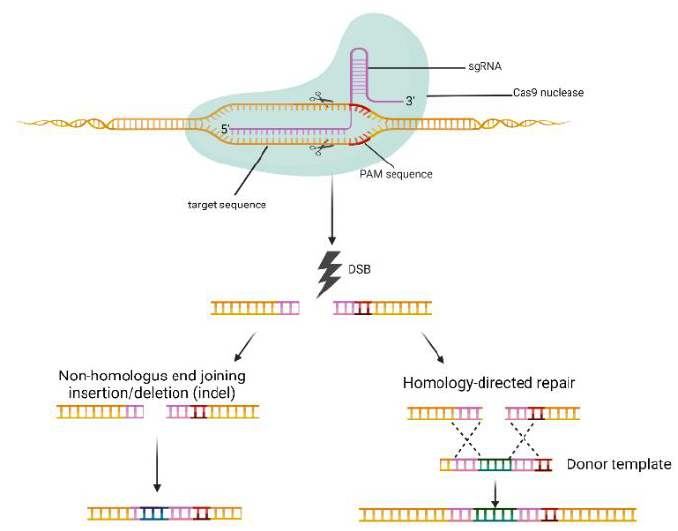
Figure 2. CRISPR/Cas9 genome editing system. Cas9 induced double-strand breaks (DSBs) at the target DNA loci. The two major DNA repair mechanisms are divided into two pathways in mammalian cells: (1) non-homologous end joining (NHEJ), and (2) homology-directed repair (HDR). The NHEJ pathway induces precise insertions or deletions (indels). The HDR mechanism uses donor DNA templates often from sister chromatids or an exogenous DNA template to generate knock-ins and base substitutions between DSB sites. The figure was created with